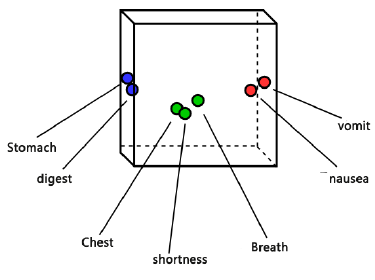
Figure 3. The visualization of